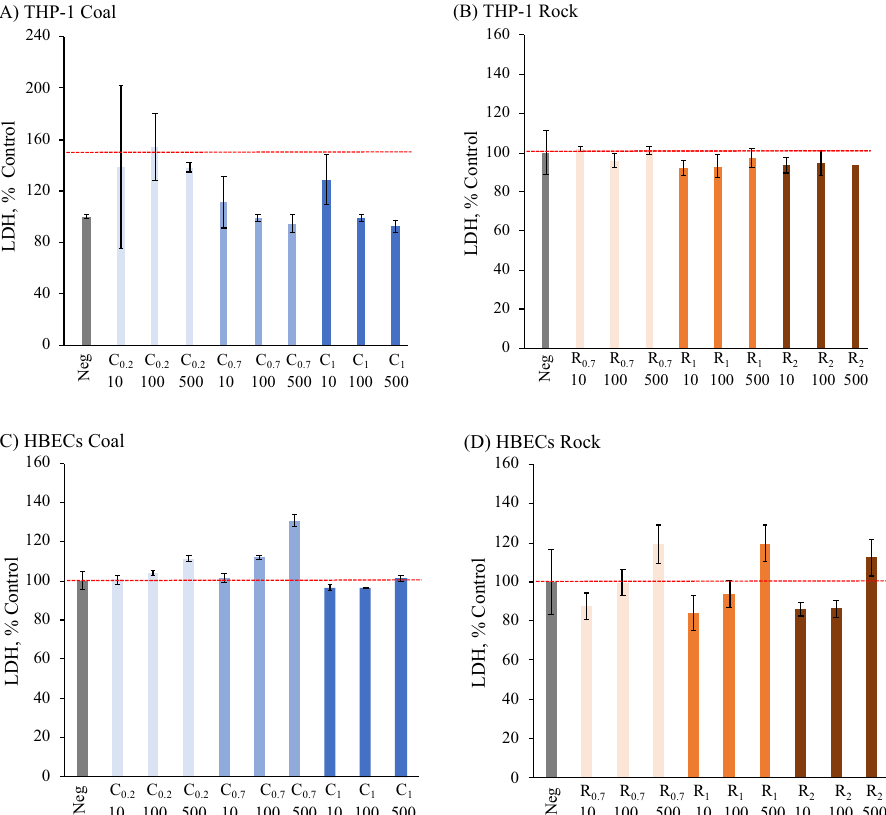
Figure 5. LDH analysis for ( A , B ) THP-1 cells and ( C , D ) HBECs of various coal and rock treatments (10, 100, 500